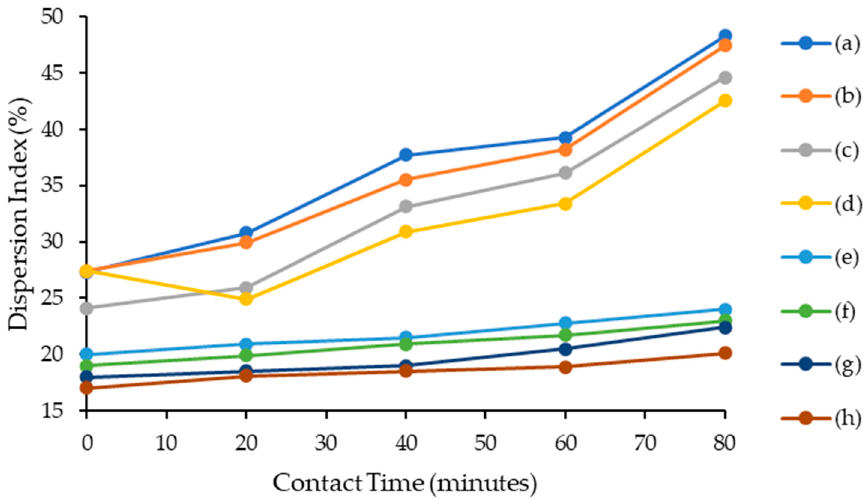
Figure 5. Contact time effect for asphaltene dispersion study. (a) [C 16 C 1 Pip] 2 [LS], (b) [C 12 C 1 Pip] 2 [LS], (c) [C 8 C1Pip] 2 [LS], (d) [C 6 C 1 Pip] 2 [LS] (e) [C 16 C 1 Pip][Cl], (f) [C 12 C 1 Pip][Cl], (g) [C 8 C 1 Pip][Cl], (h) [C 6 C 1